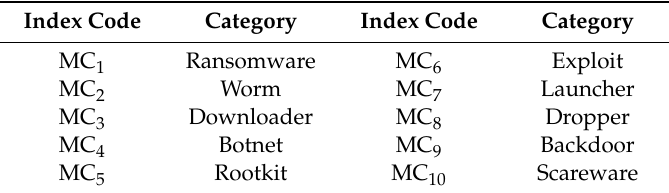
Table 1. Malware categories (MCs).